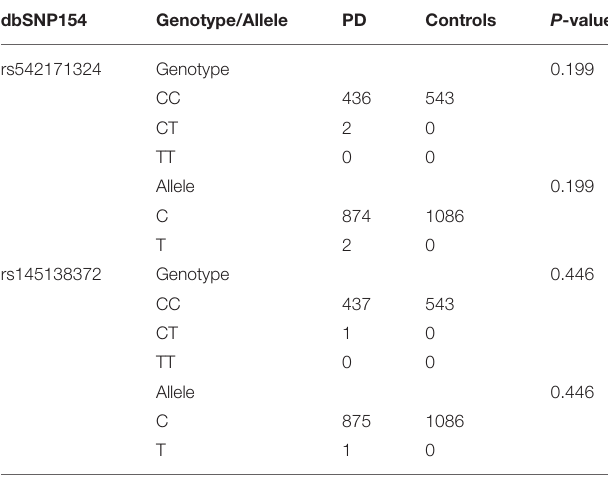
TABLE 2 | Genotypic and allelic distributions of rs542171324 and rs145138372 in the Han Chinese patients with PD and